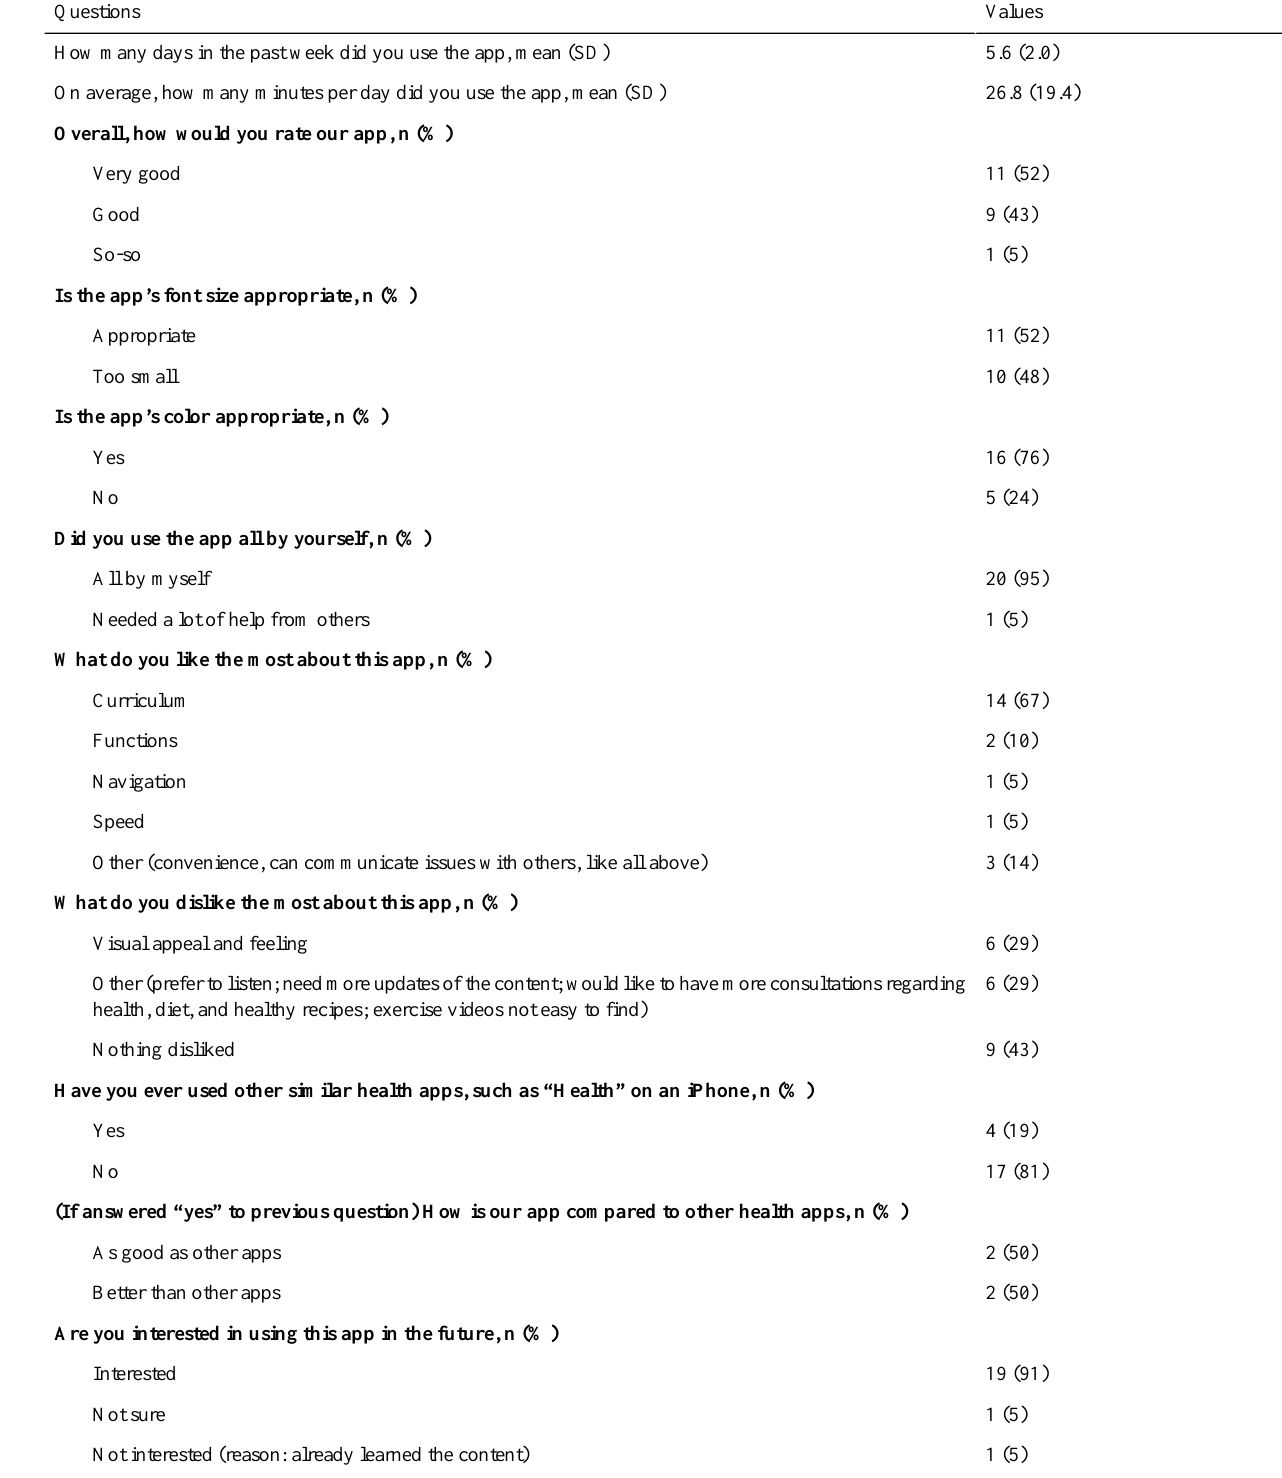
Table 3. App ratings after the 1-week at-home use.